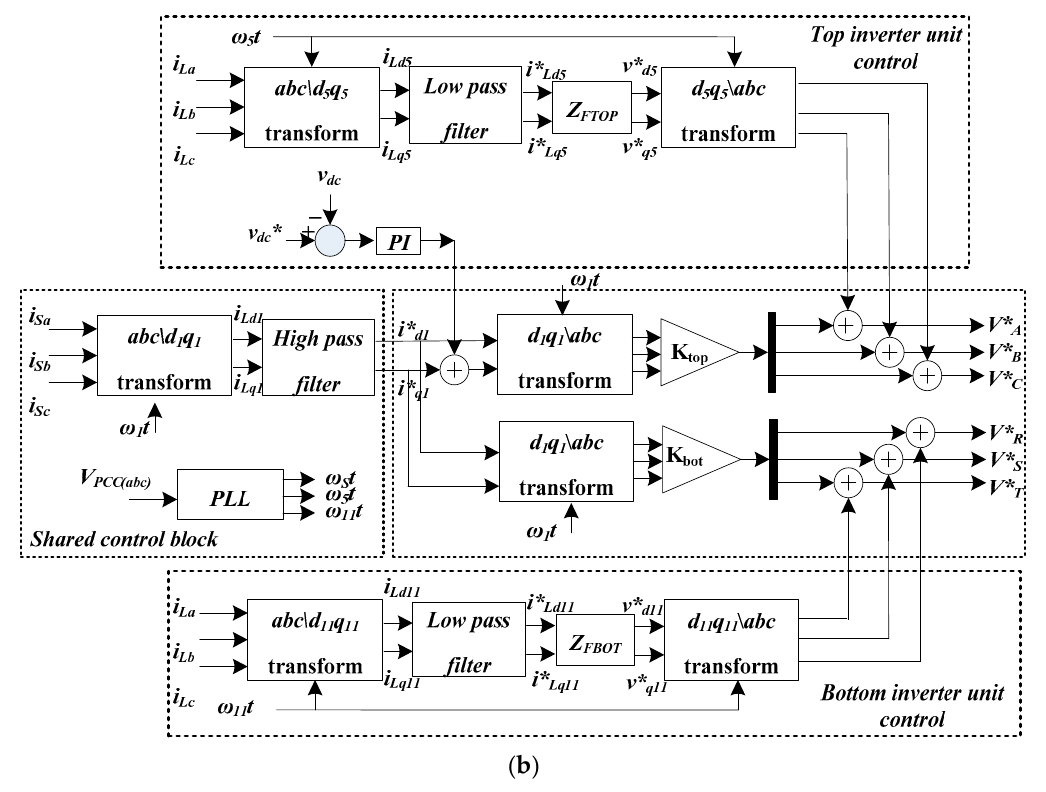
Figure 9. ( a ) AC–AC inverter topology and ( b ) control block of the proposed hybrid power filter based on SSTL inverter.